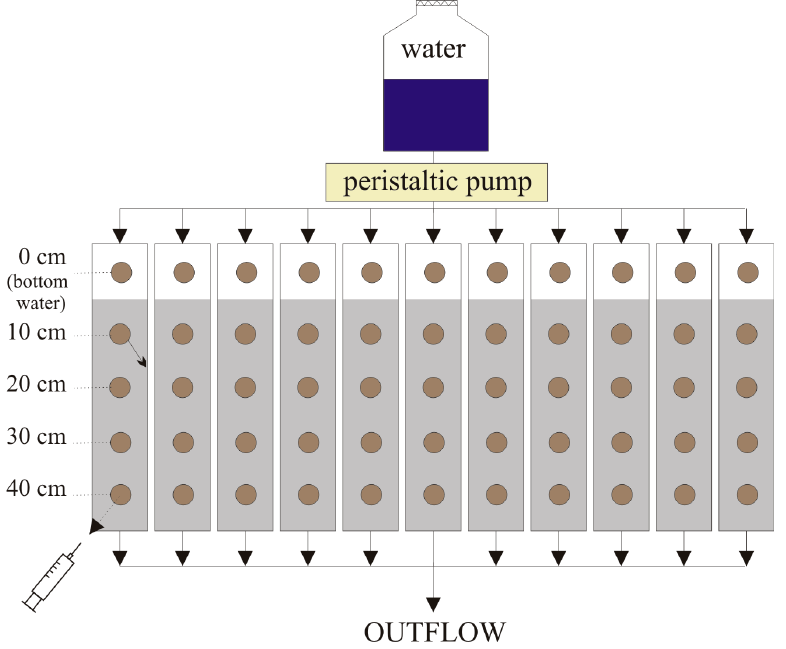
Figure 3. Diagram of the columns used in the experiment.